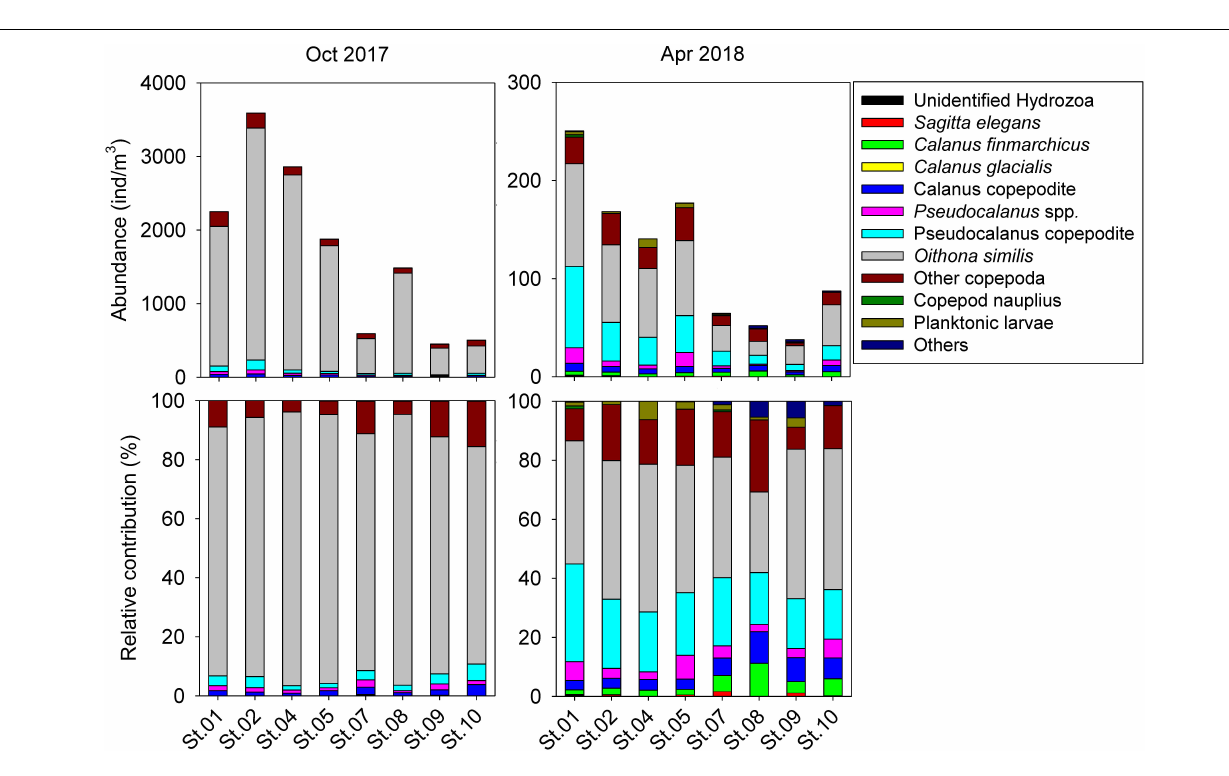
Trophic dynamics in zooplankton species may indicate changes in integrated diets before and after polar night. Cases of temporal TP variation before and after polar night are displayed in Figure 5 and inform the following